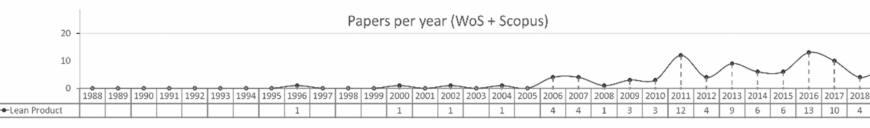
Figure 13. Lean product evolution.